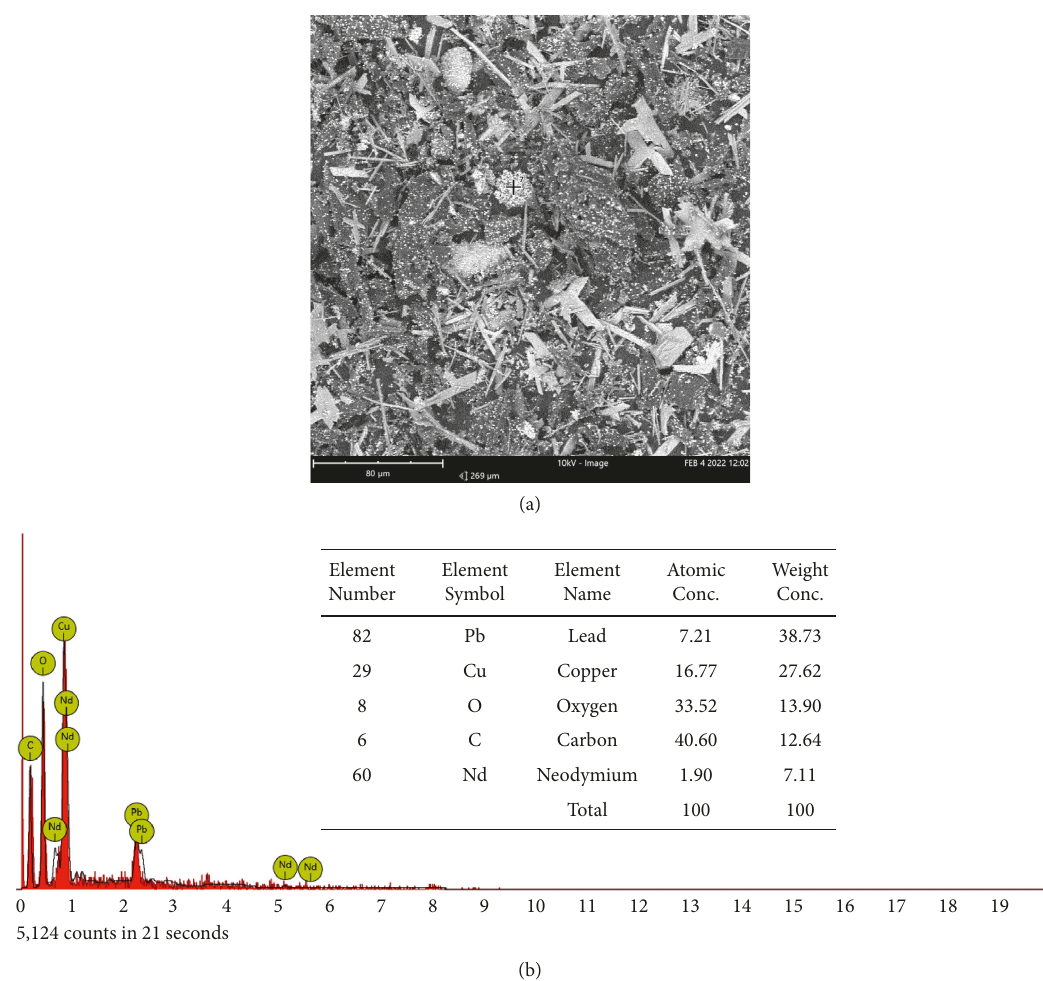
Figure 10: (a) BSED image of the BAC-Zn adsorbent after adsorption showing the spectrum used for EDX analysis. (b) The corresponding EDX spectrum at the spectrum point as indicated in (a).